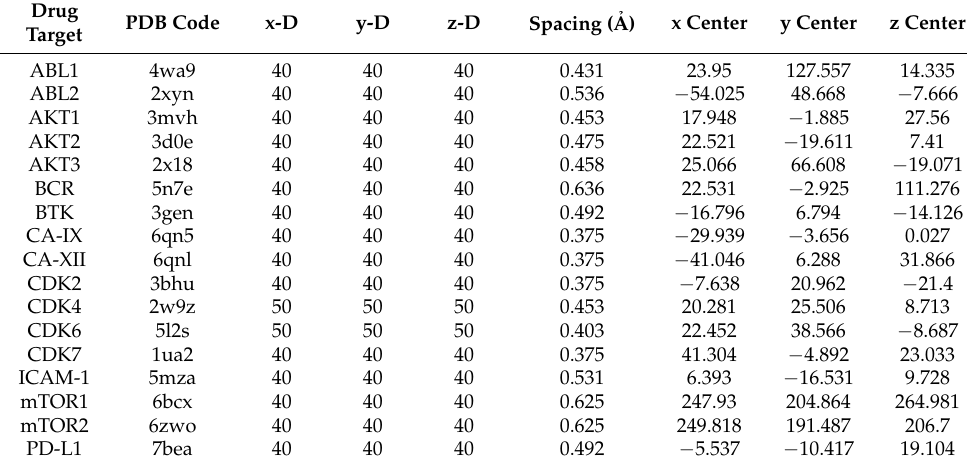
Table 3. The coordinates of the grid box for all the anticancer targets used in the current study. Drug